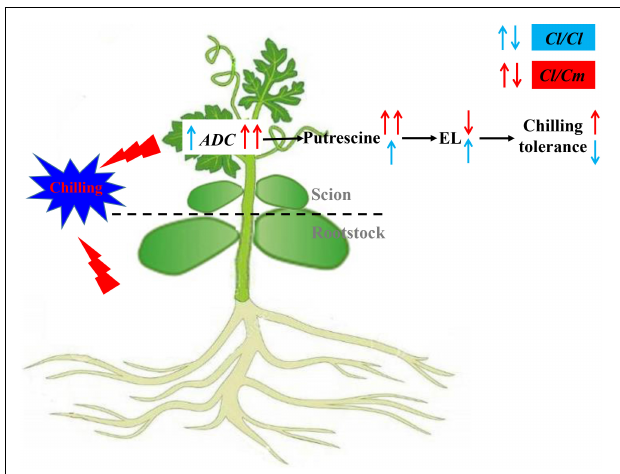
FIGURE 8 | Proposed model for putrescine involved in pumpkin grafted induced chilling tolerance in watermelon plants. Pumpkin rootstock grafting increased ADC expression and putrescine accumulation, decreased electrolyte leakage under chilling stress, thus increasing chilling tolerance. Red arrows represent pumpkin rootstock-increased chilling tolerance; Blue arrows represent watermelon rootstock-caused chilling